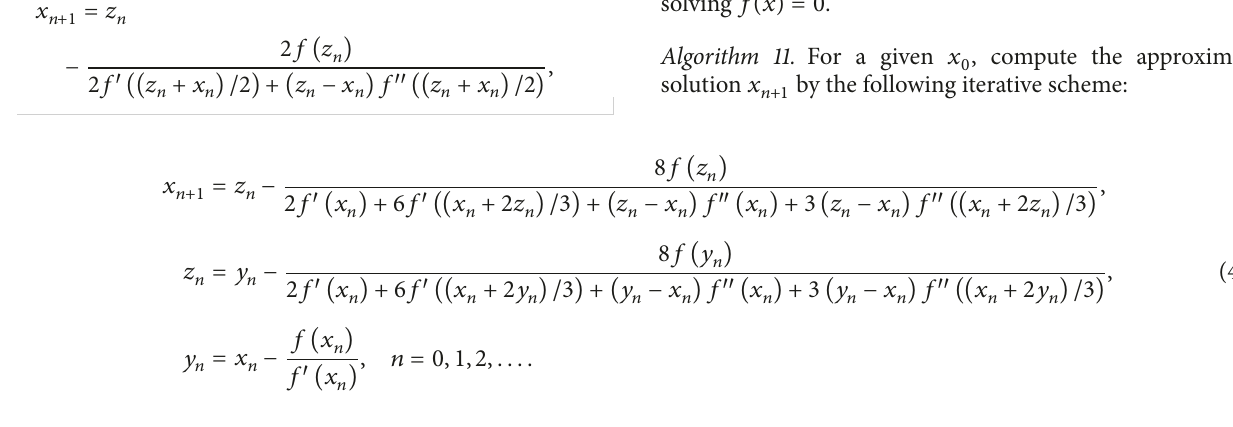
Algorithm 10. For a given 𝑥 0 , compute the approximate